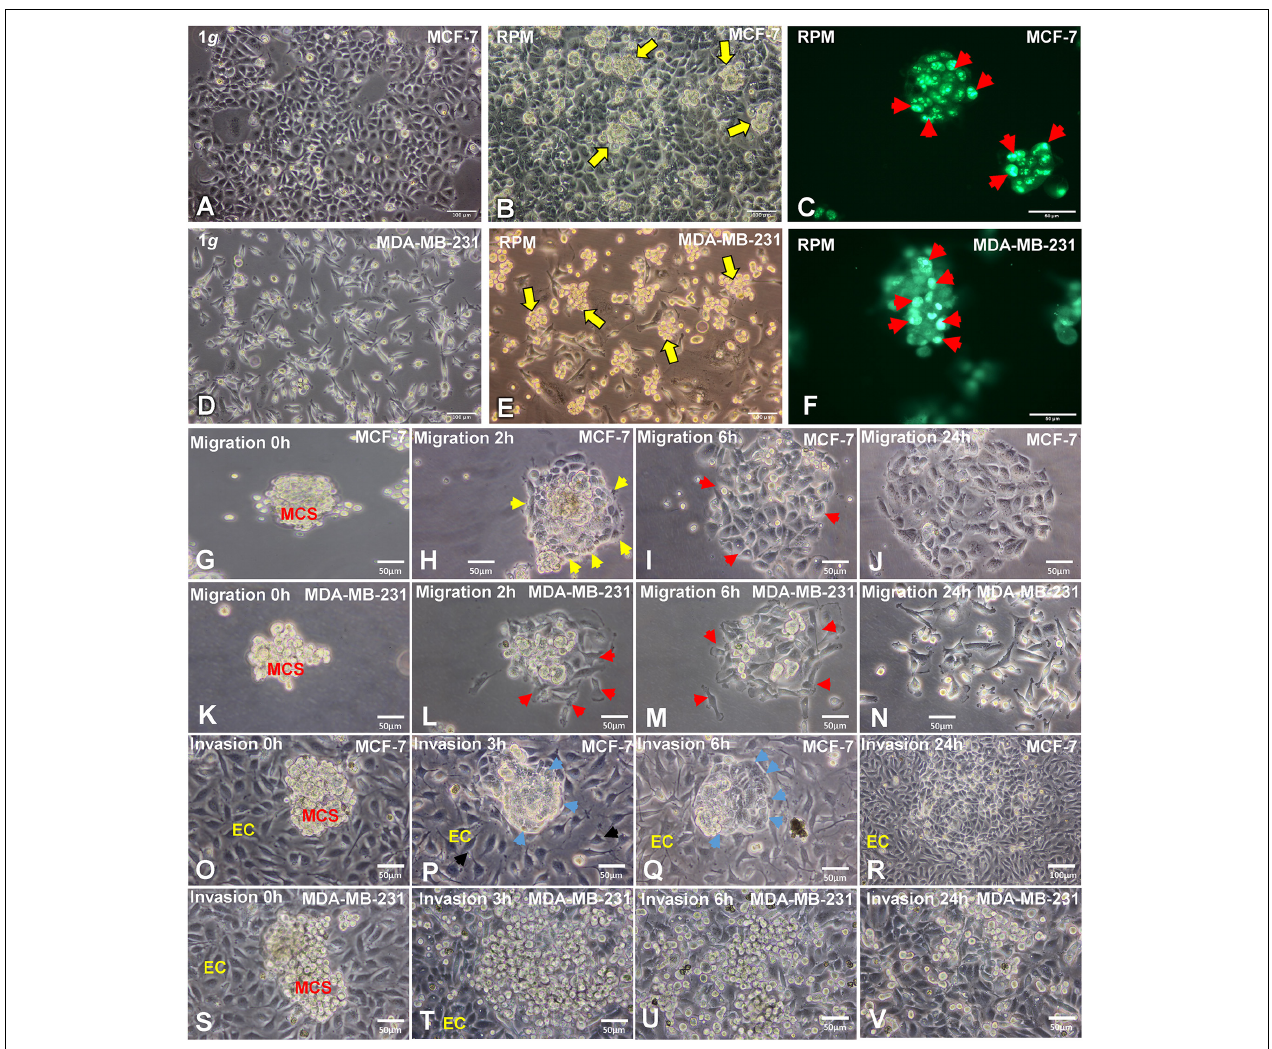
FIGURE 1 | Phase contrast microscopy of MCF-7 and MDA-MB-231 breast cancer cells (BCC). (A) Characteristic epithelial morphology of the MCF-7 cell line cultured at 1 g . (B) Adherent MCF-7 cells and multiple compact multicellular spheroids (MCS, yellow arrows) were visible when the MCF-7 cells were exposed to the random positioning machine (RPM) for 24 h. (C) Ki-67 immunofluorescence staining (IFS) of MCF-7 MCS. The red arrows show Ki-67 positive nuclei. (D) MDA-MB-231 cell line cultured under static 1 g control conditions at 24 h. (E) MDA-MB-231 cells exposed to the RPM for 24 h. Multiple multicellular spheroids (yellow arrows) are visible as well as adherent cells. Magnification × 100. The yellow arrows indicate MCS floating in the supernatant of the cell cultures. (F) Ki-67 IFS of MDA-MB-231 MCS. The red arrows show Ki-67 positive nuclei. (G) Migration behavior of the MCF-7 cells in spheroids at 0 h, (H) 2h, the yellow arrows indicate the attachment of the MCS on the slide flask bottom and the cell membrane. (I) 6 h, the red arrows show areas of migration and (J) 24 h. (K) Migration behavior of MDA-MB-231 cells in spheroids at 0 h, (L) 2 h, the red arrows show the attached MCS and migration (M) 6 h, red arrows indicate migrated cells and after (N) 24 h. No MCS were visible at this time point. Invasion test: co-cultures of EA.hy926 endothelial cells and MCF-7 MCS. (O) 0 h, (P,Q) 3 h and 6h, the blue arrows show the formation of a cellular membrane. (R) After 24 h the MCF-7 BCC had invaded the endothelial cells. Invasion test: co-cultures of EA.hy926 endothelial cells and MDA-MB-231 MCS. (S) 0 h, (T) 3 h, at this time point the MDA-MB-231 cells had already migrated out of the MCS and showed an invasive growth. (U) 6 h and (V) 24